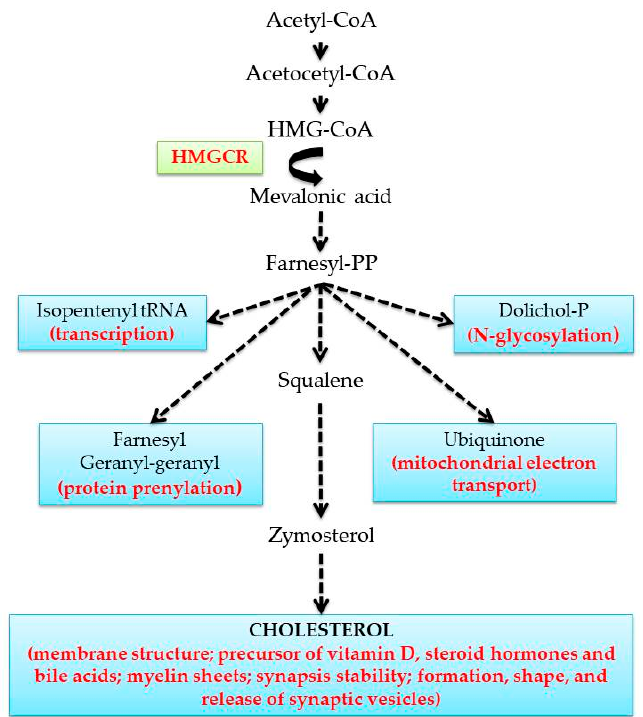
Figure 1. Schematic representation of the mevalonate (MVA) pathway and its end-product